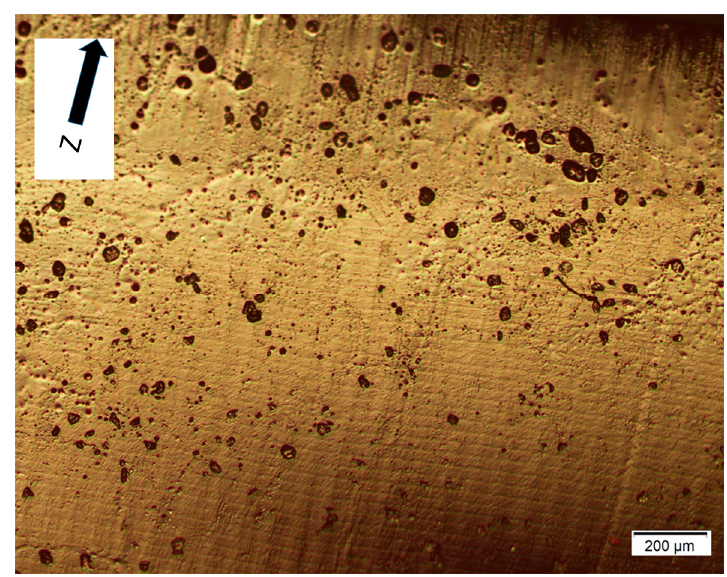
Figure 7. Castable Blend. Fracture section of edge sample. ( a ) Layer thickness; ( b ) Vertical lines due to columns of pixels.